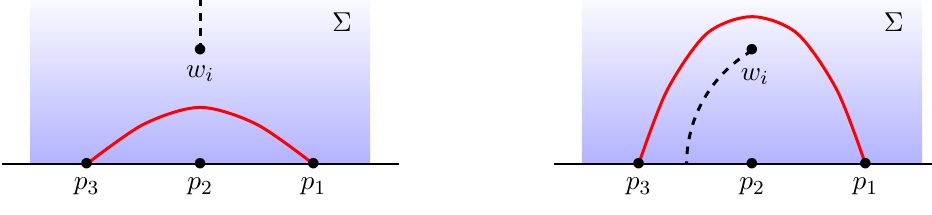
Figure 2 . Integration contours for the constraint in (4.23), depending on whether or not the branch cut intersects the boundary in the interval ( p 3 ; p 1